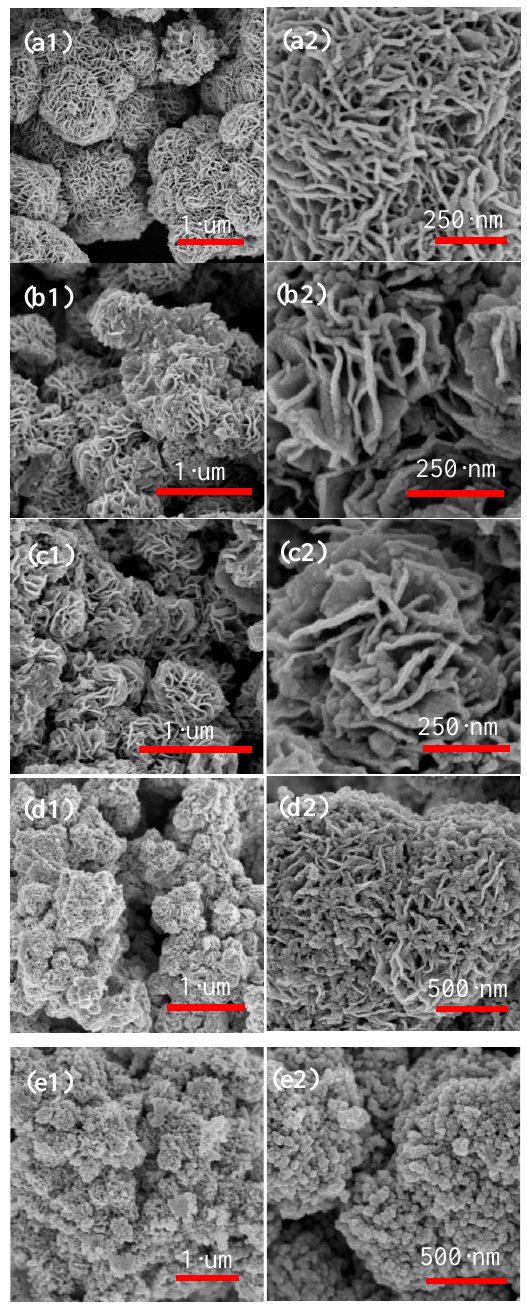
Figure 5. ( a ) Scanning electron microscopy (SEM) of pure MoS 2 , ( b ) sample S1, ( c ) sample S2, ( d ) sample S3, ( e ) sample S4.